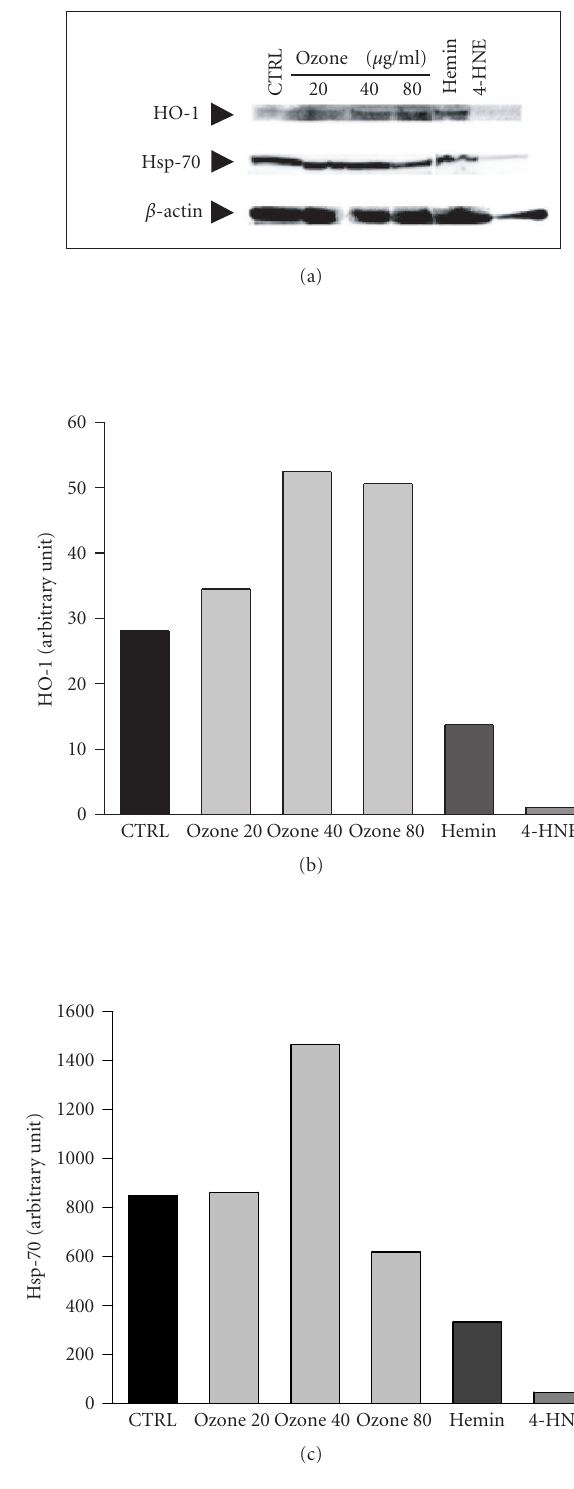
Figure 2: Ozonated human plasma, particularly at the medium ozone concentration of 40 μ g/mL per mL of blood activates both HO-1 and Hsp-70 in human endothelial cells. The signals of both protein levels were determined by densitometric analysis of the scanned images. Data are expressed as arbitrary units. One repre- sentative Western blot of a typical experiment is shown in the top